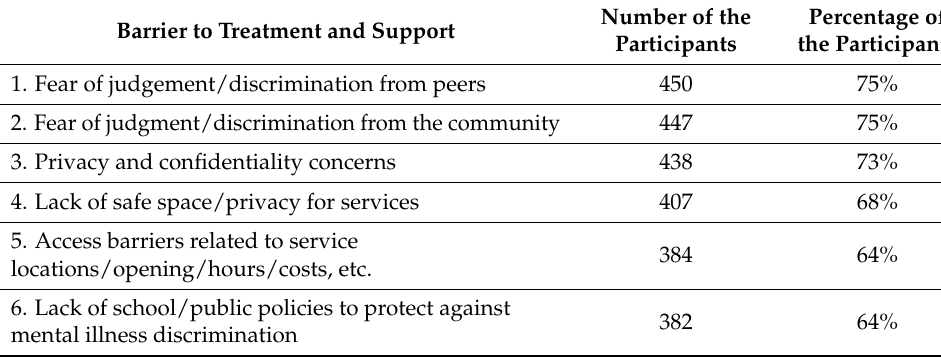
Table 1. Top six barriers to treatment and support. Barrier to Treatment and Support